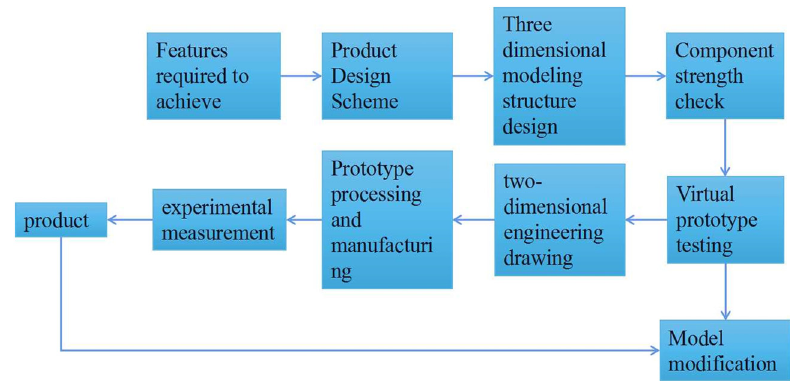
Figure 1: Mechanical structure development.